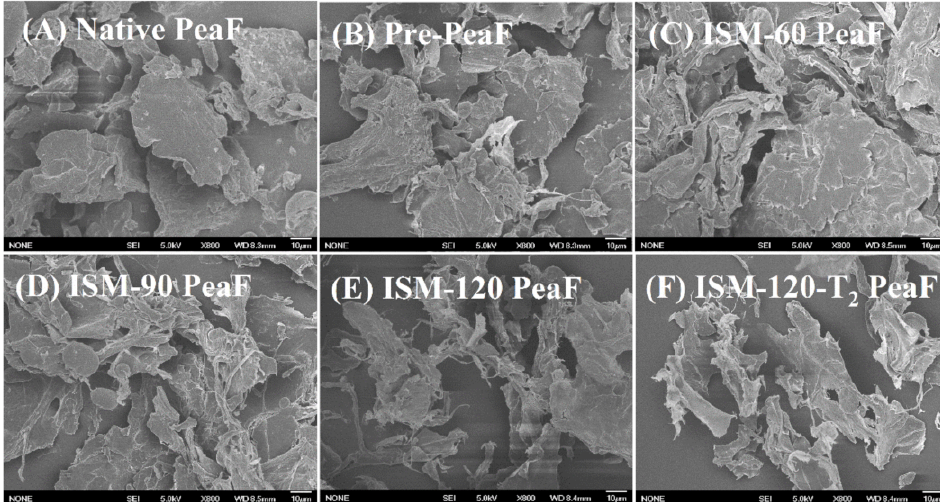
Figure 3. SEM micrographs. Magnification was 800 ×